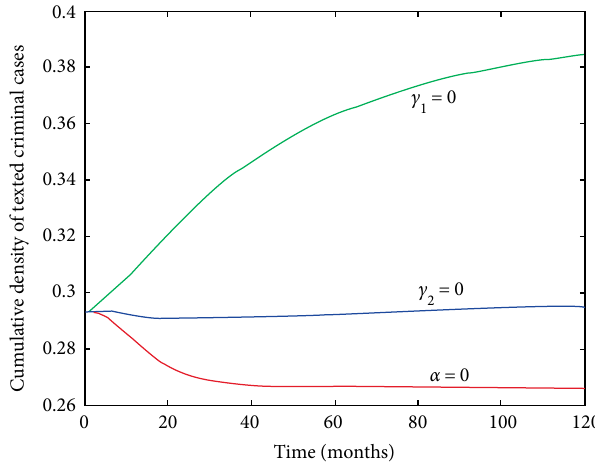
Figure 15: Simulation of model (4) showing the effect of combinations of variable values of , and on the cumulative density of texted 𝛾 1 𝛾 2 𝛼 criminal cases as a function of time. Other parameter values used are as given in Table